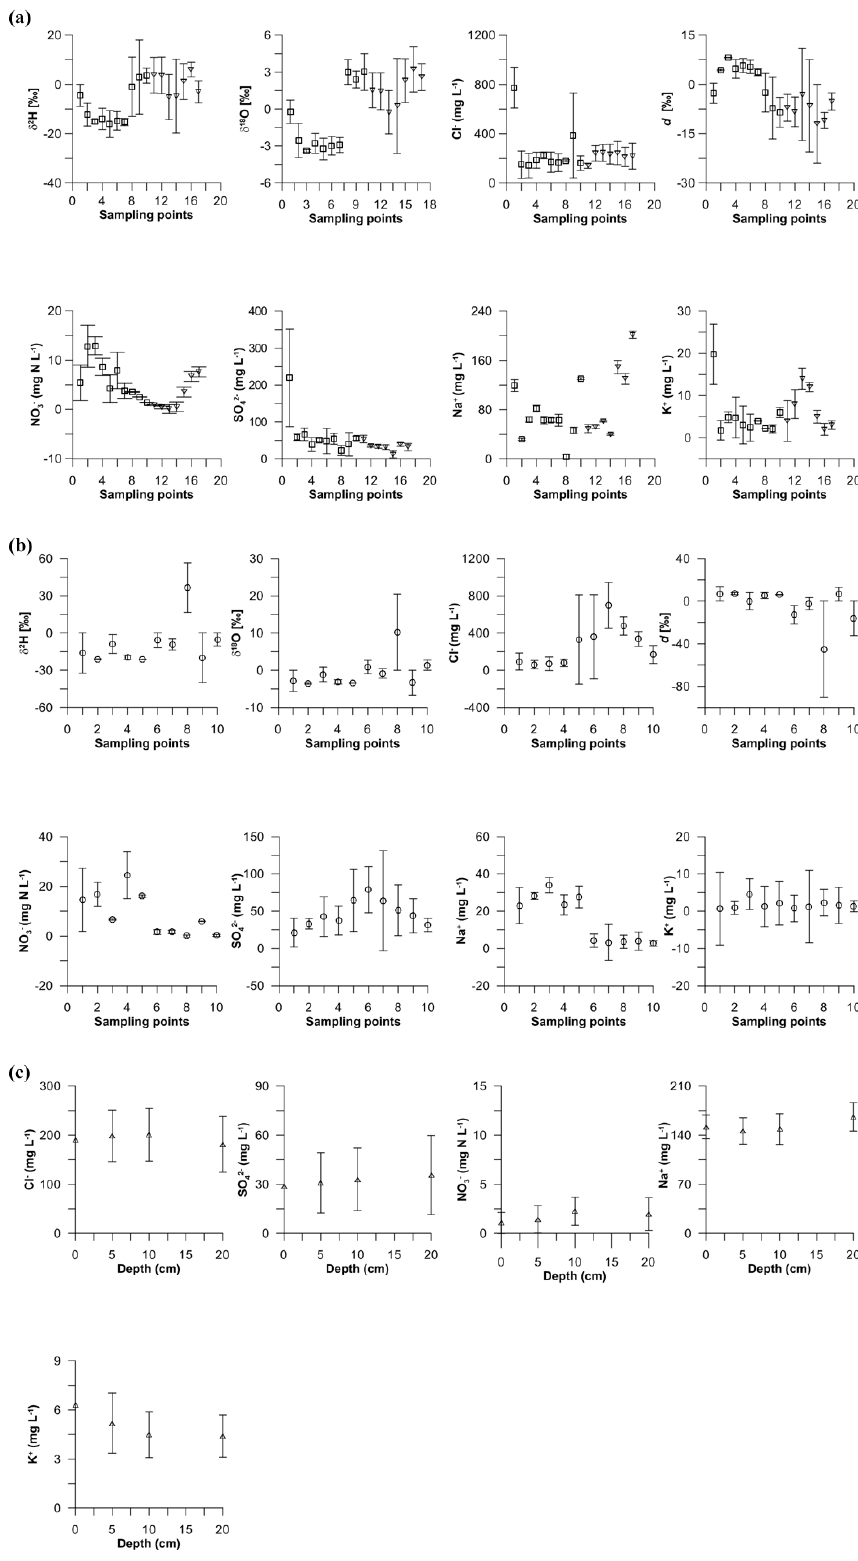
, Na + , NO − and K + in: (a) surface water (squares indicate the Chamin´e river to 4 3